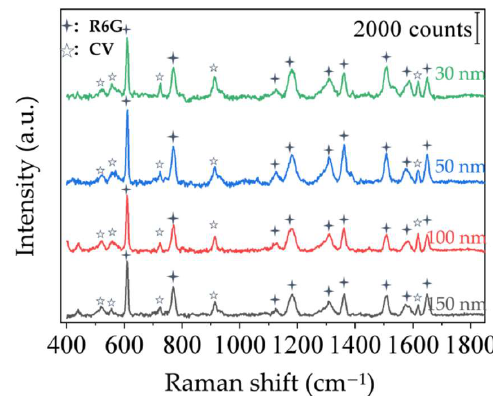
Figure 7. Raman measurement of R6G and CV simultaneously on sample Ag@SiO 2 –30.